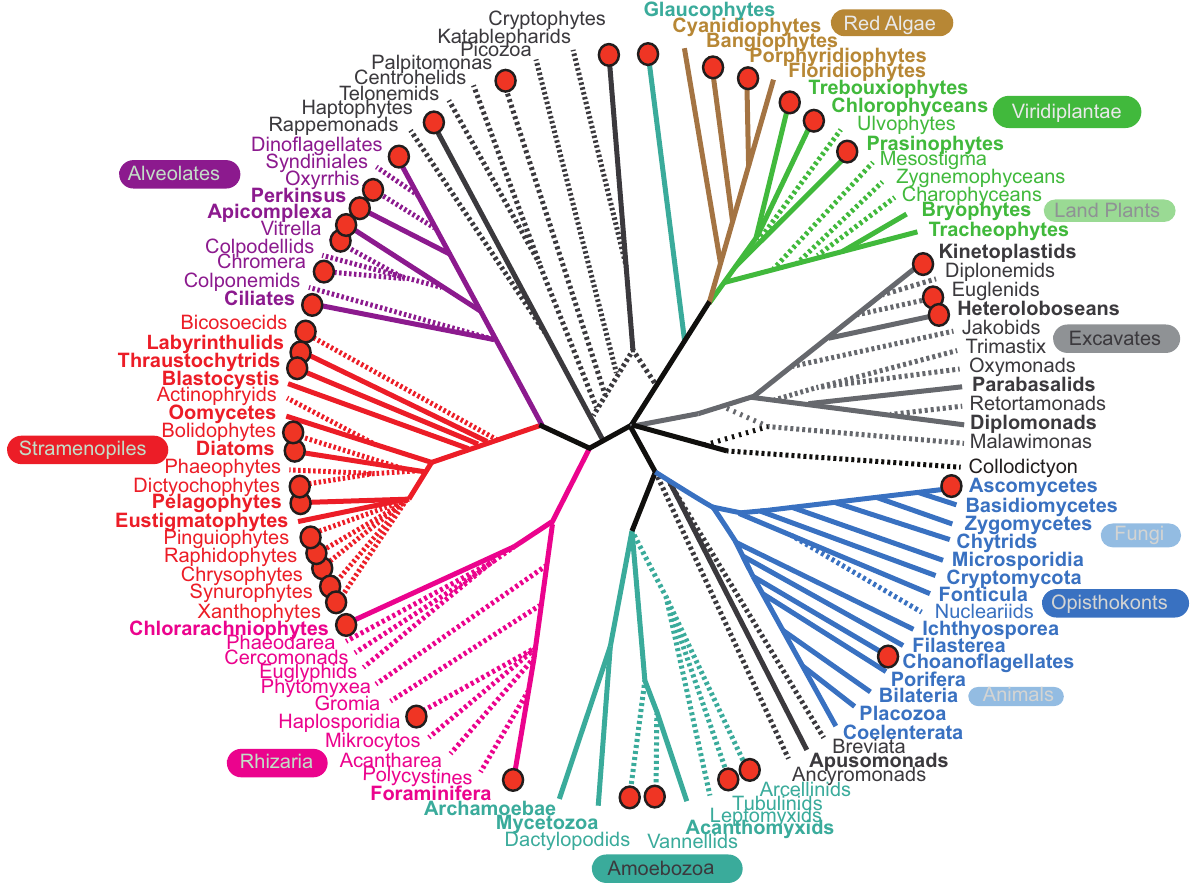
Figure 2. A schematic of the major lineages in the eukaryotic tree of life, showing the relationships between lineages for which genomic resources are currently available and those that have been targeted by the MMETSP. Lineages with complete genomes according to the GOLD database, as summarized in [3], are indicated by a solid line leading to that group, whereas lineages with no complete genome are represented by a dashed line. Lineages where at least one MMETSP transcriptome is complete or underway are indicated with a red dot by the name. Major lineages discussed in the text have been named and color-coded, but for clarity, some major lineages have not been labeled.